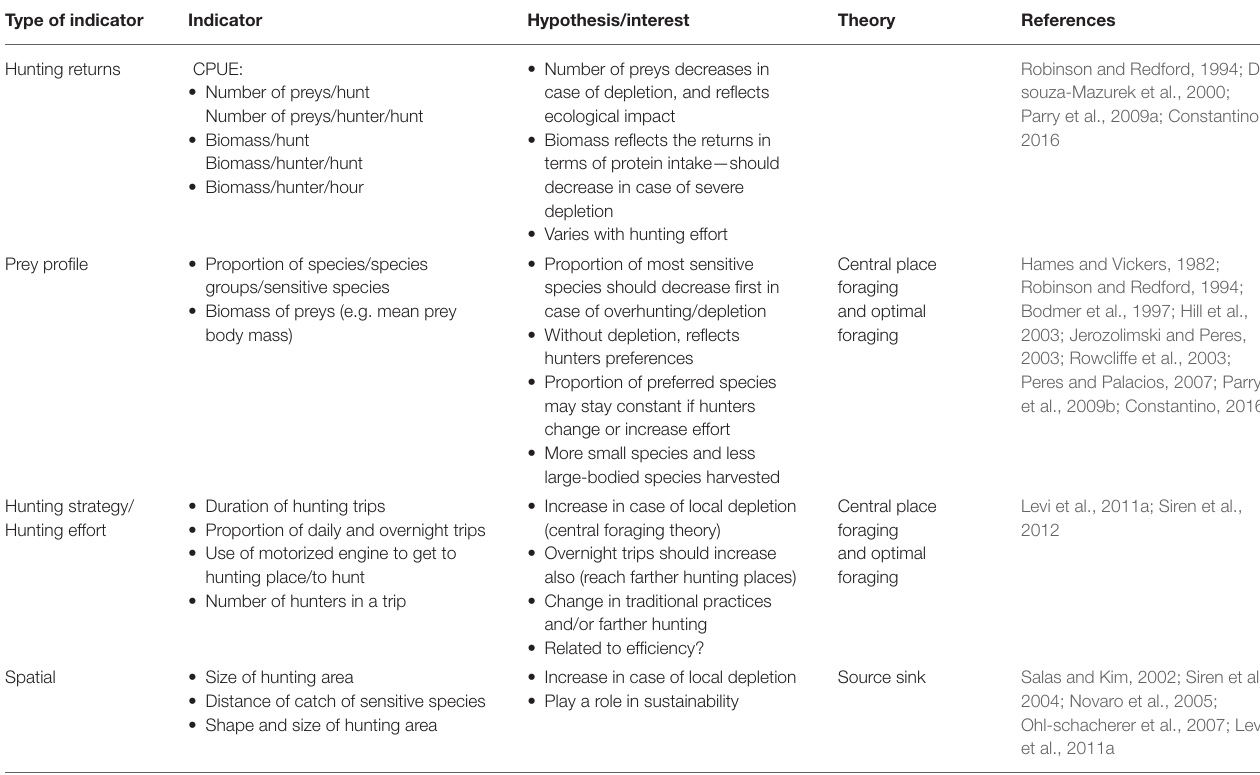
TABLE 2 | Variables, indicators and related hypothesis used to explore the hunting impact and practices in French